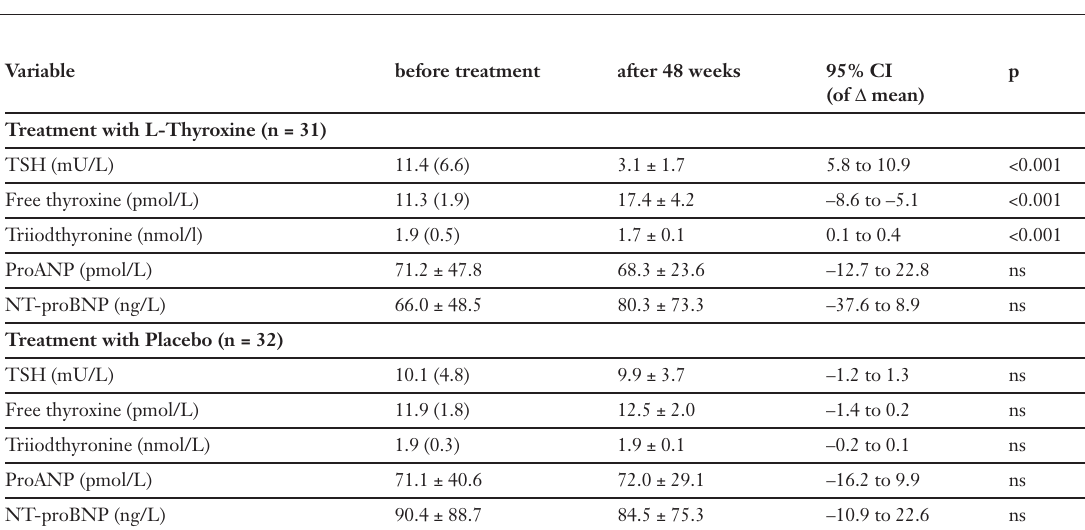
Table 2 Parameters of women with subclini- cal hypothyroidism before and after L-T4 or placebo